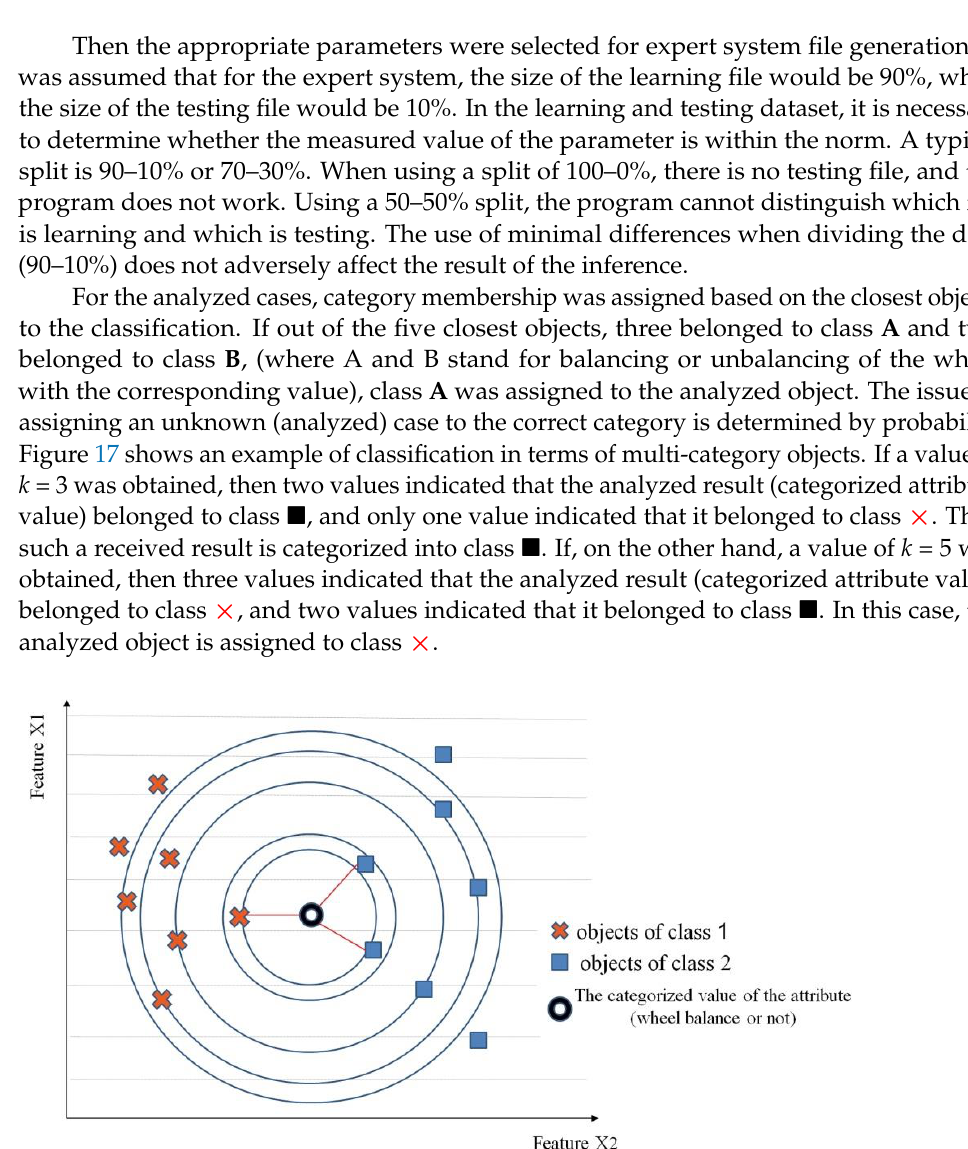
Figure 16. View of the data fragment in the expert system — input data (in).